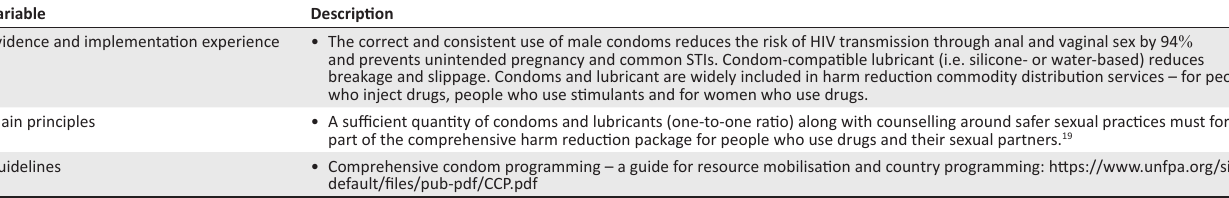
TABLE 12: HIV prevention – condoms and lubricant. 19